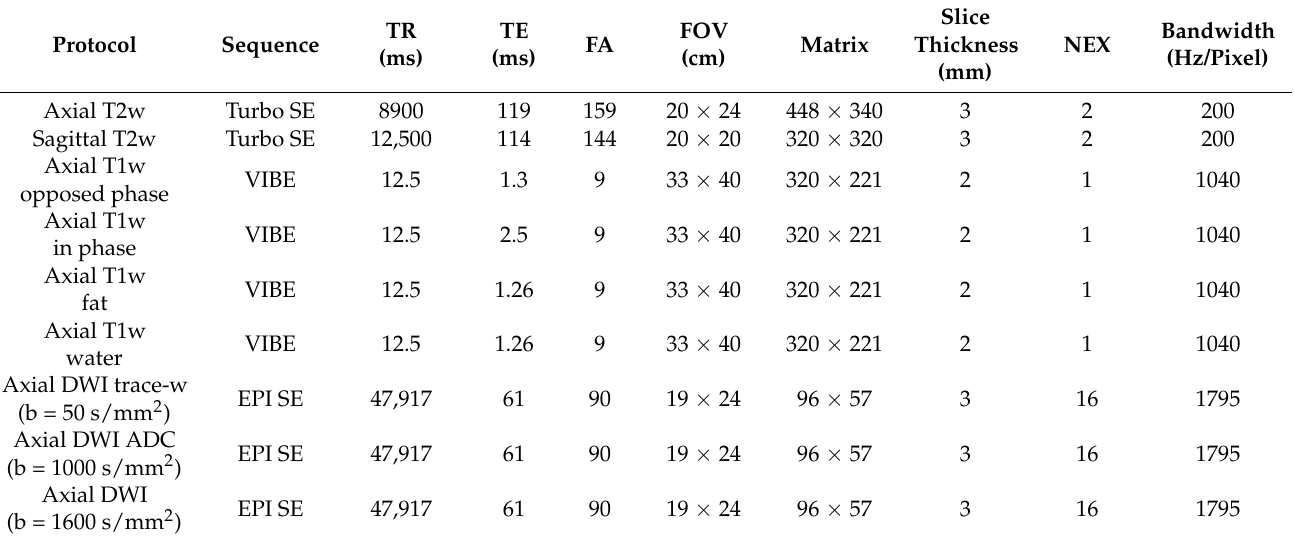
Table 1. MRI acquisition